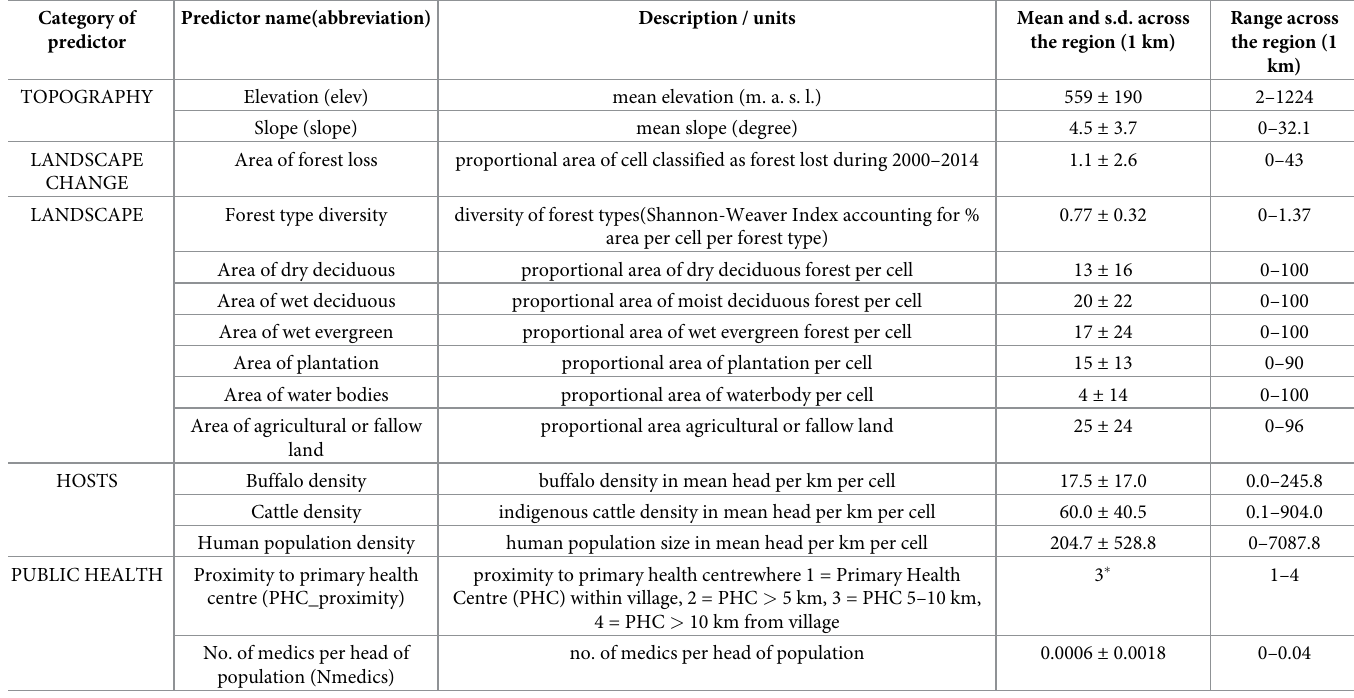
Table 2. Potential environmental predictors included in models of Kyasanur Forest Disease distribution†. Category of